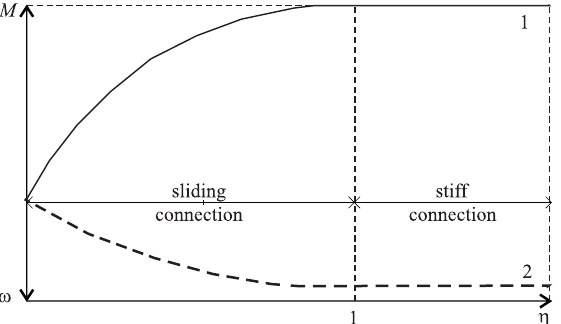
Fig. 2. The scheme of the effect of connections and their stiffness ( D con ) on the resistance (1) and the deflections (2) of a layered structure